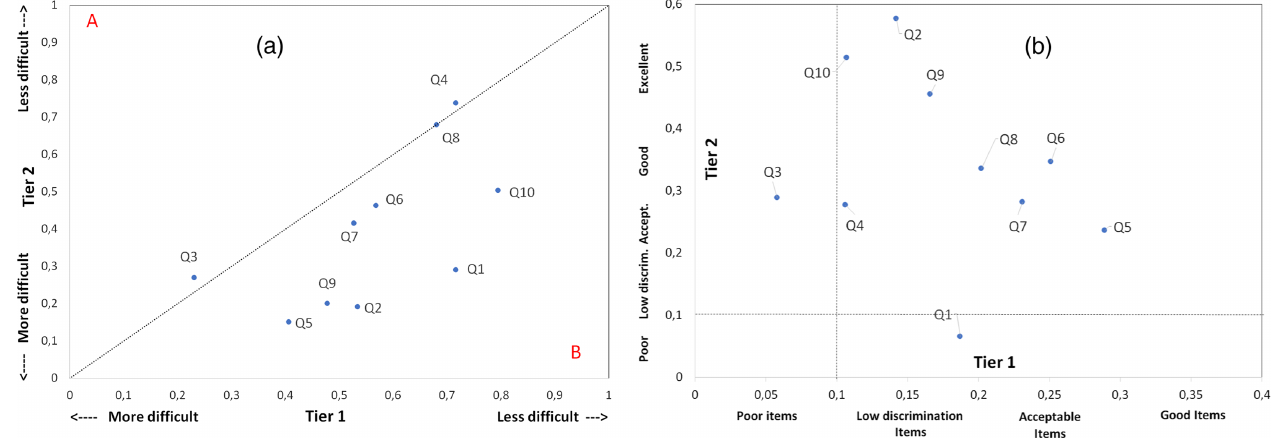
FIG. 1. (a) Dispersion plot of the QME items ’ difficulty in the T1 – T2 plane when tiers are analyzed separately. See text for the definition of regions A and B. See Table V for further details. (b) Dispersion plot of QME items discrimination in the T1 – T2 plane when tiers are analyzed separately. Straight dotted lines indicate the 0.1 threshold under which items have poor discrimination power. See Table V for further details.